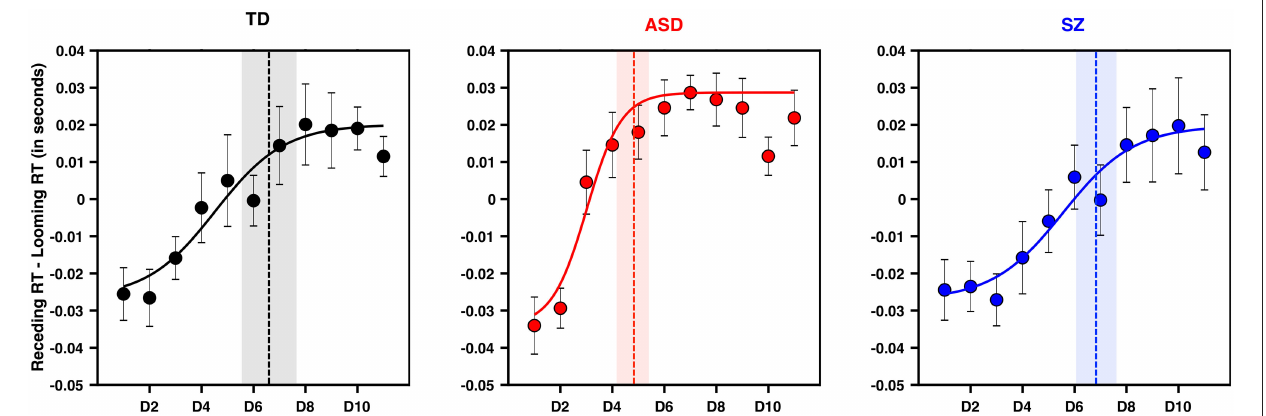
FIGURE 3 | PPS is smaller and sharper in ASD than TD and SZ. Y-axis is the difference between tactile RTs during approaching and receding visual stimuli when matched for time. X-axis is distance, in the frame of reference of the approaching stimuli. Namely, D1 corresponds to D1 for approaching, and D11 for receding (which are matched in time). Negative values along the y-axis indicate a further facilitation as a function of distance for approaching than for receding visual stimuli, as would be expected of a PPS effect. Error bars are ± 1S.E.M., the vertical line in each panel (TD = black, ASD = red, SZ = blue) is the average central point of the sigmoidal fit (the fit shown is for the average subject). Shaded area is ±